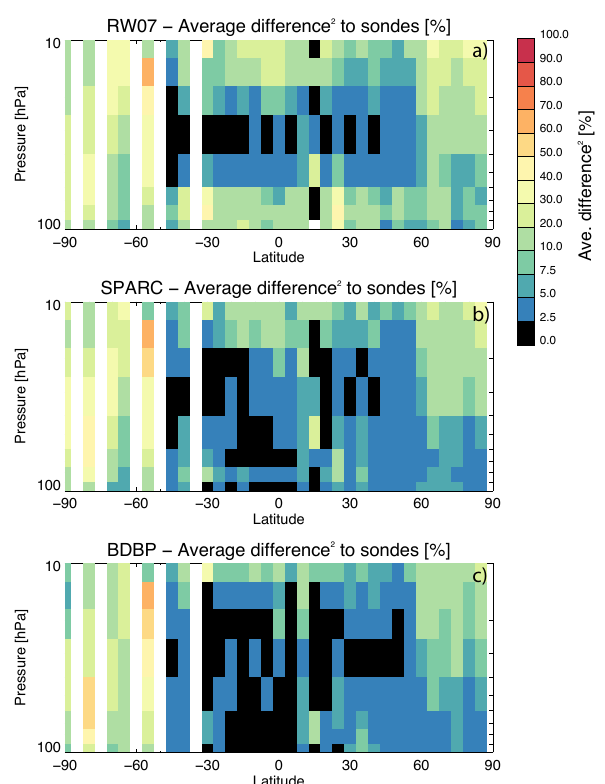
Figure 11. Average squared difference between all available monthly mean ozone sonde 2 Fig. 11. Average squared difference between all available monthly mean ozone sonde values for given latitude bands and pressure lev- values for given latitude bands and pressure levels (obtained from Hassler et al., 2009), and 3 els, and (a) the RW07 data set, (b) the SPARC data set, and (c) the (a) the RW07 data set, (b) the SPARC data set, and (c) the BDBP data set, given in percent. 4 BDBP data set, given in percent. Note that for RW07 at 100hPa Note, that for RW07 at 100 hPa some monthly means are not available between 20°S and 5 some monthly means are not available between 20 ◦ S and 25 ◦ N 25°N due to missing tropospheric data. Colours changing from black to red indicate a change 6 due to missing tropospheric data. Colours changing from black to in average squared differences from 0% to 100%. 7 red indicate a change in average squared differences from 0% to